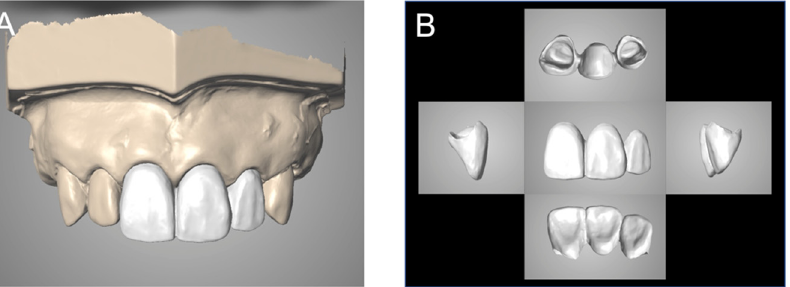
Figure 6. The digital wax-up of definitive restoration was completed by the intra- and extra-oral scanning (IEOS) technique. ( A ) Provisional restoration attached. ( B ) Provisional restoration.